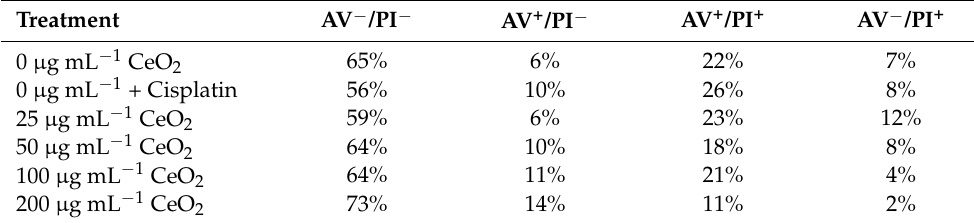
Table 4. Flow cytometry gated profiles of viable (AV − /PI − ), early apoptotic (AV + /PI − ), apoptotic and necrotic (AV + /PI + ), and already dead (AV − /PI + ) cells treated with varying concentrations of CeO 2 NP, or Cisplatin and irradiated with 10 Gy ionizing